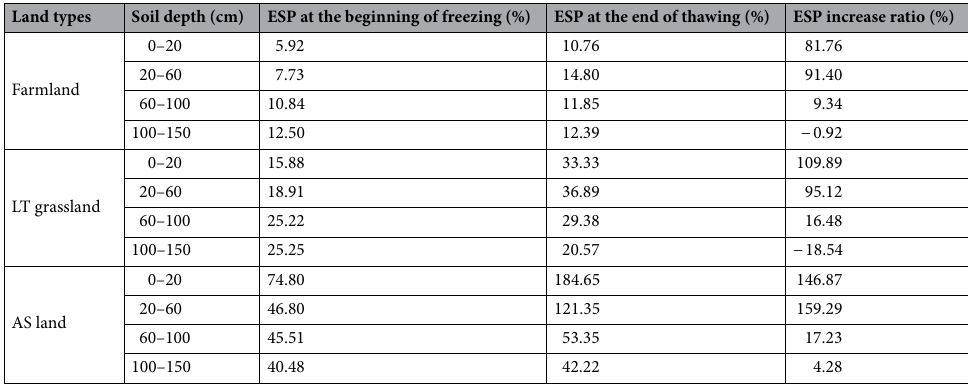
Table 5. Soil ESP increase ratio of farmland, LT grassland and AS land in freeze–thaw processes.